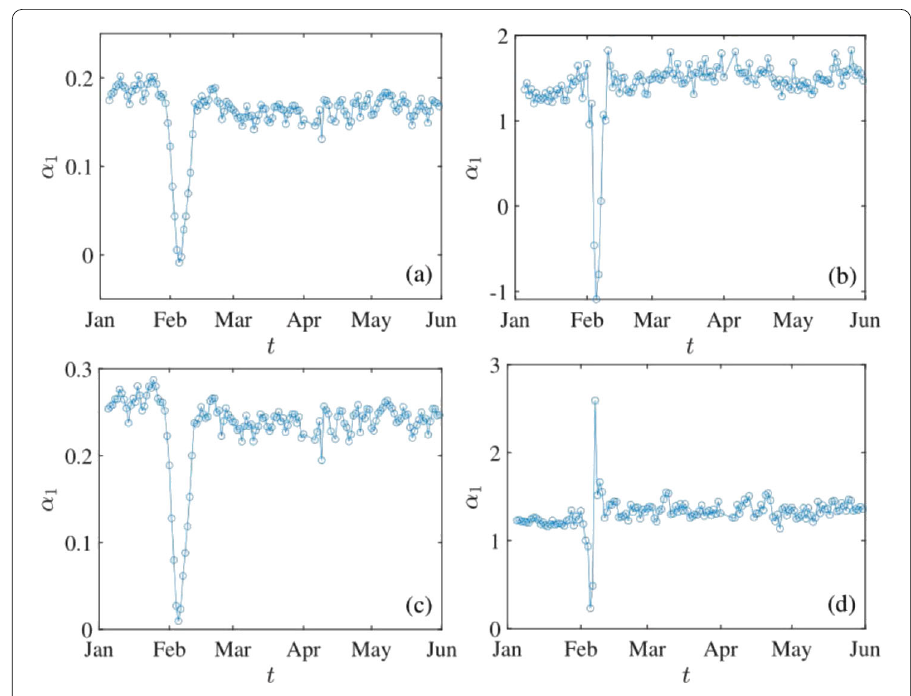
Figure 9 Evolution of the exponents α 1 of daily directed and undirected freight highway transportation networks. ( a ) Scatter data of F ij with respect to ( G i / P i )( G j / P j )/ d 2 for the directed network. ( b ) Binning data of F ij ij with respect to ( G i / P i )( G j / P j )/ d 2 ij for the directed network. ( c ) Scatter data of W ij with respect to ( G i / P i )( G j / P j )/ d 2